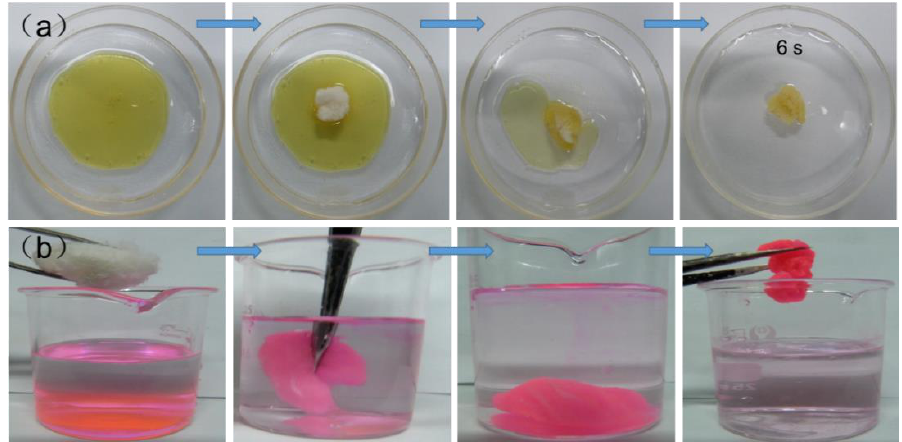
Figure 6. Absorption of pump oil ( a ) and chloroform ( b ) by CF 3:2 . Chloroform was colored with Rhodamine B.